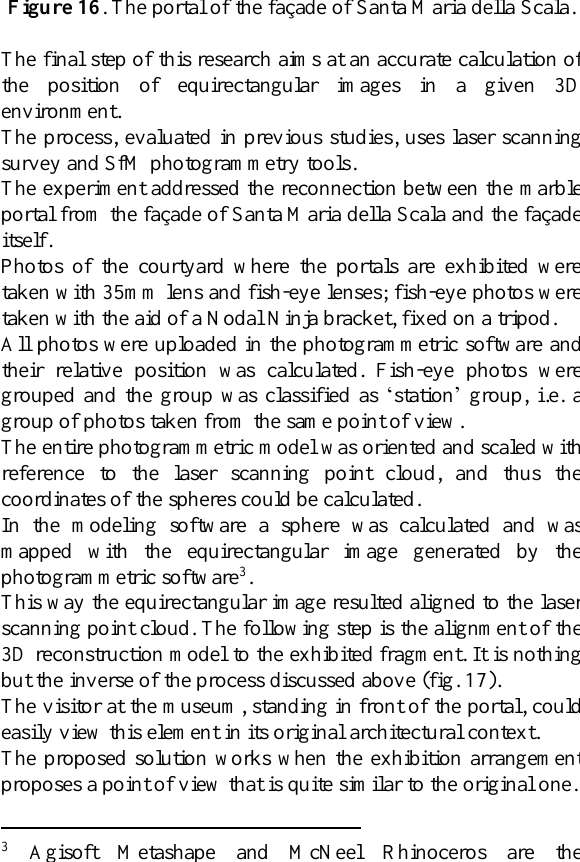
Figure 15 . Palazzo Grano’s corbels repositioned.